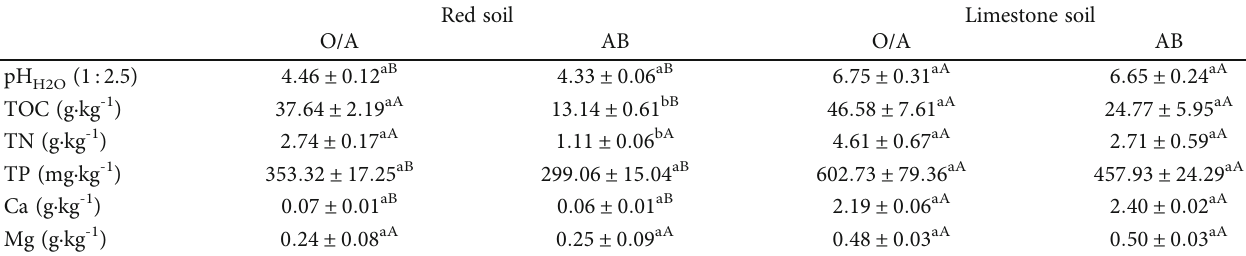
Table 1: Physiochemical properties in soil of O/A and AB horizons of the red soil and limestone soil. Red soil Limestone